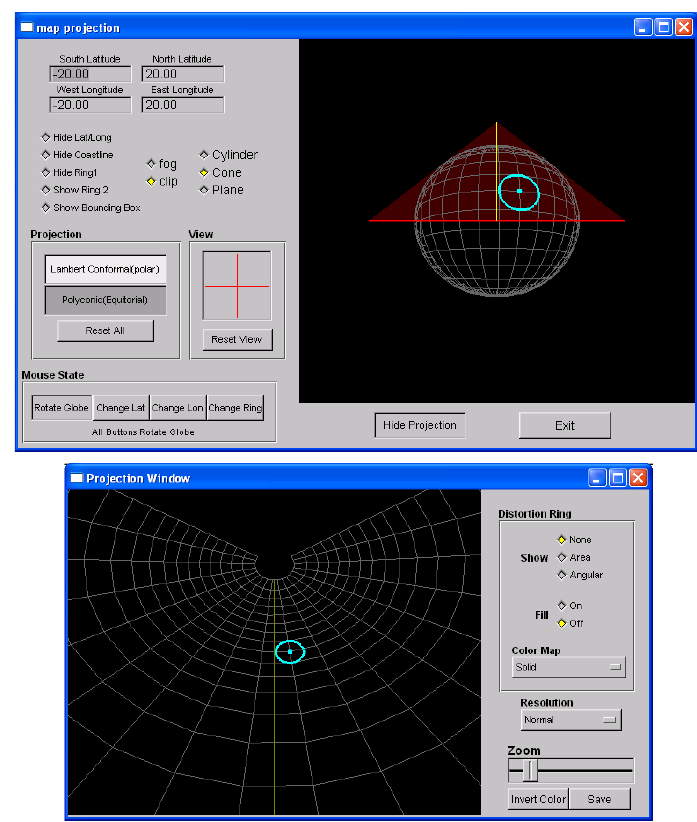
Fig. 11. A window of the mapwin